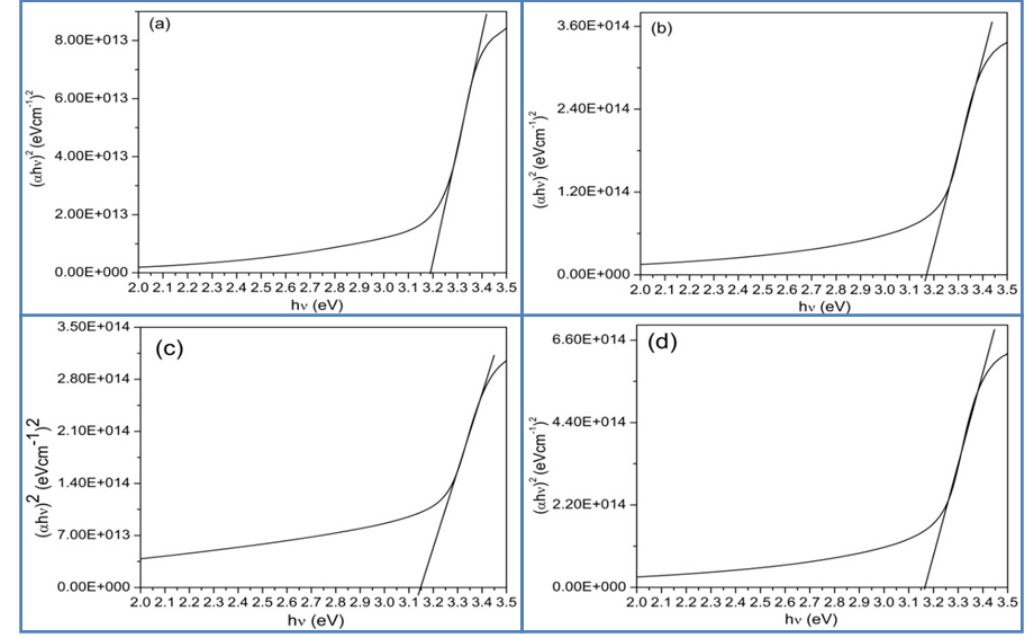
Figure 15. Variation of ( α h ν ) 2 versus applied energy (h ν ) of the synthesized ZnO nanorods using modified CBD method at several concentration, ( a ) 0.01 M, ( b ) 0.025 M, ( c ) 0.05 M and ( d ) 0.075 M.